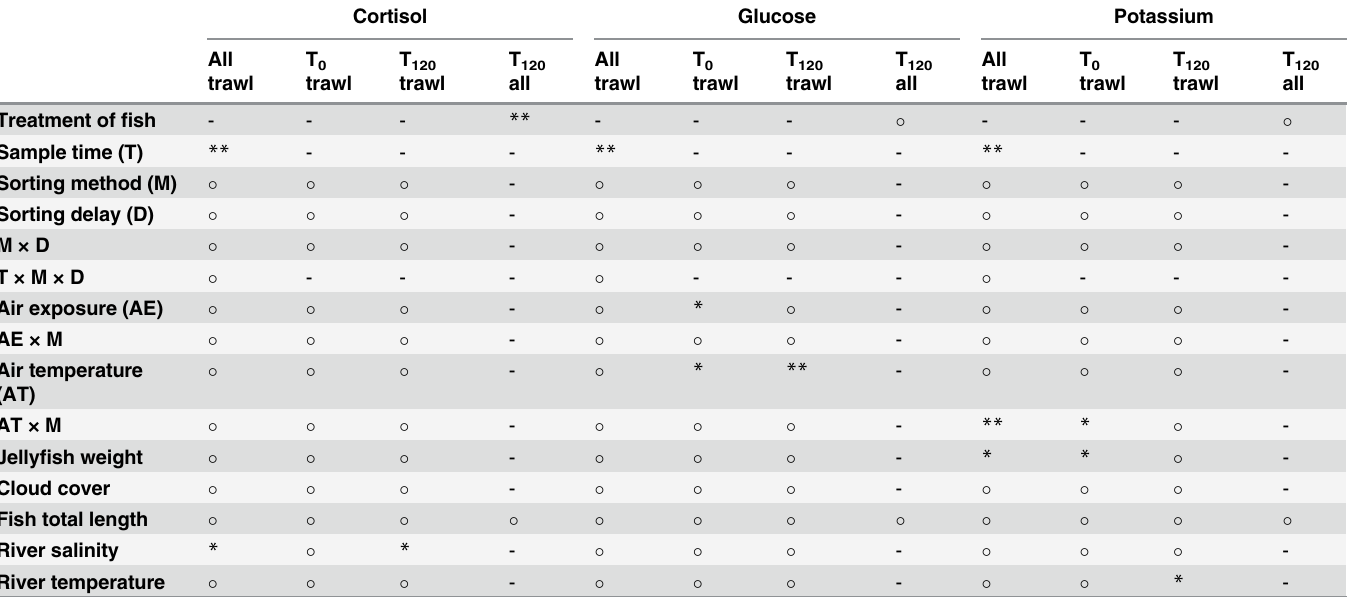
Table 3. Summary of variables (fixed effects) tested in linear mixed models for their independence in explaining variability among plasma cortisol, glucose and potassium concentrations in yellowfin bream ( Acanthopagrus australis